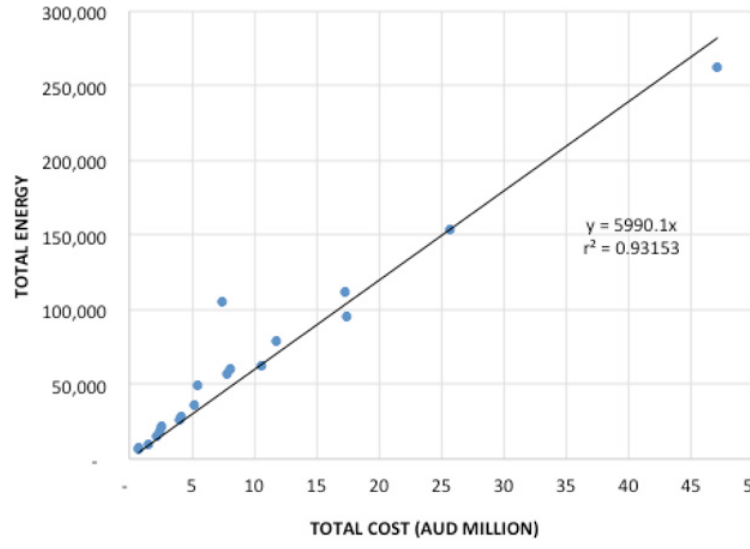
Figure 4 New-build EE versus Cost (Melbourne)